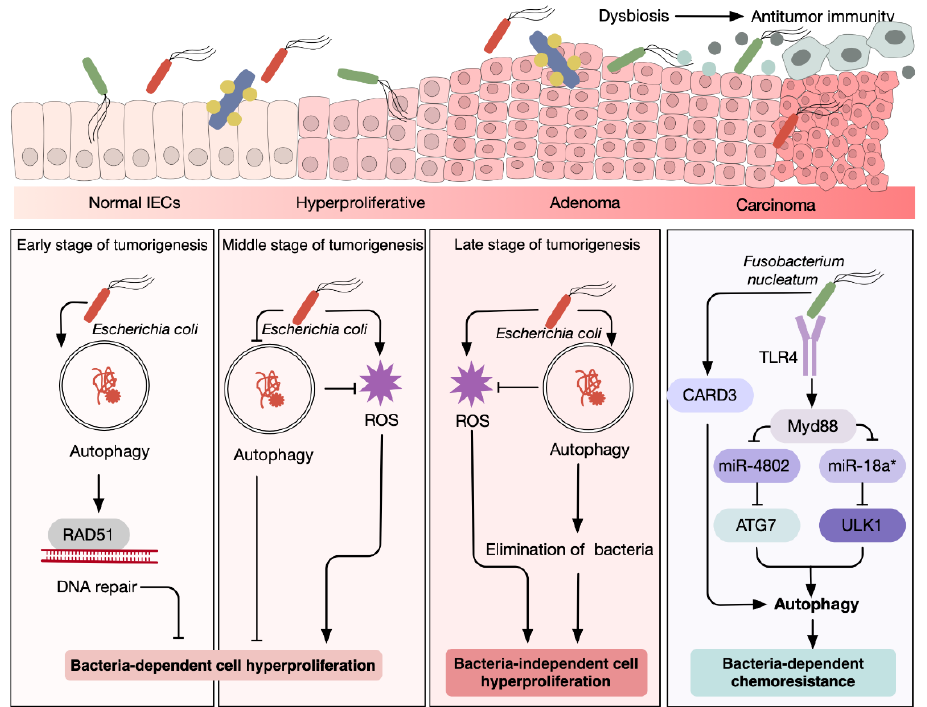
Figure 5. Distinct roles of autophagy in microbiota-induced stress. Sporadic CRC is driven by sequential genetic and epigenetic mutations, and environmental factors, arising from normal epithelial cells to dysplastic adenomas and, ultimately, carcinomas. During this process, a link between CRC tumorigenesis, infection with certain bacteria, and autophagy has been established. Time-dependent interactions between autophagy and intestinal bacteria are shown.